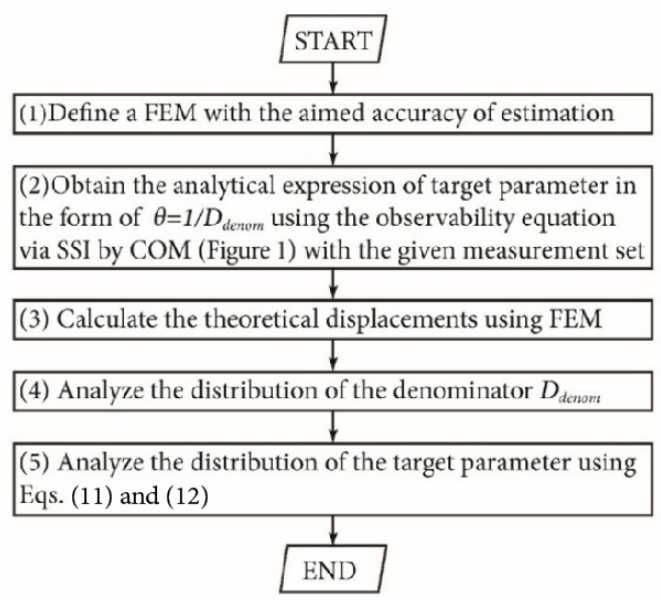
Figure 2. Procedure for the statistical analysis of target parameters.